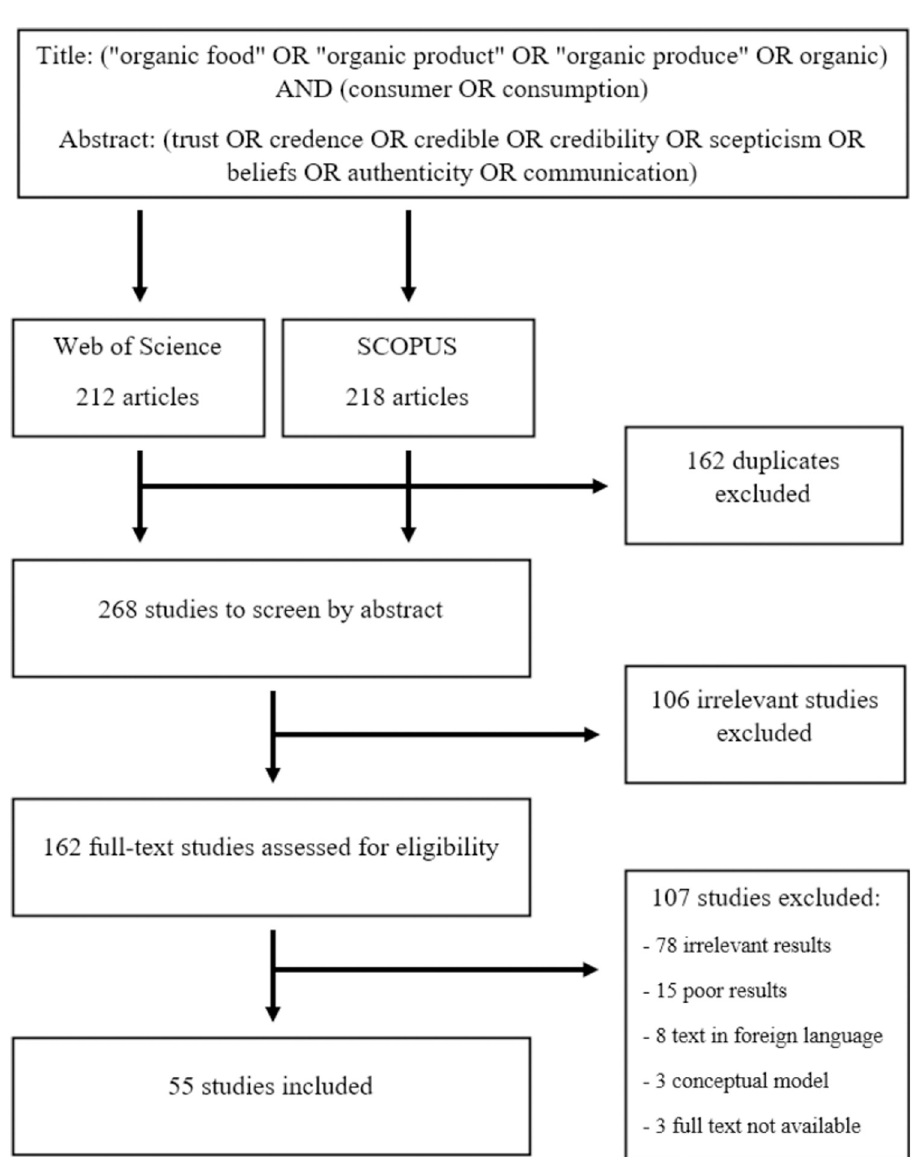
Fig 1. Search words and search